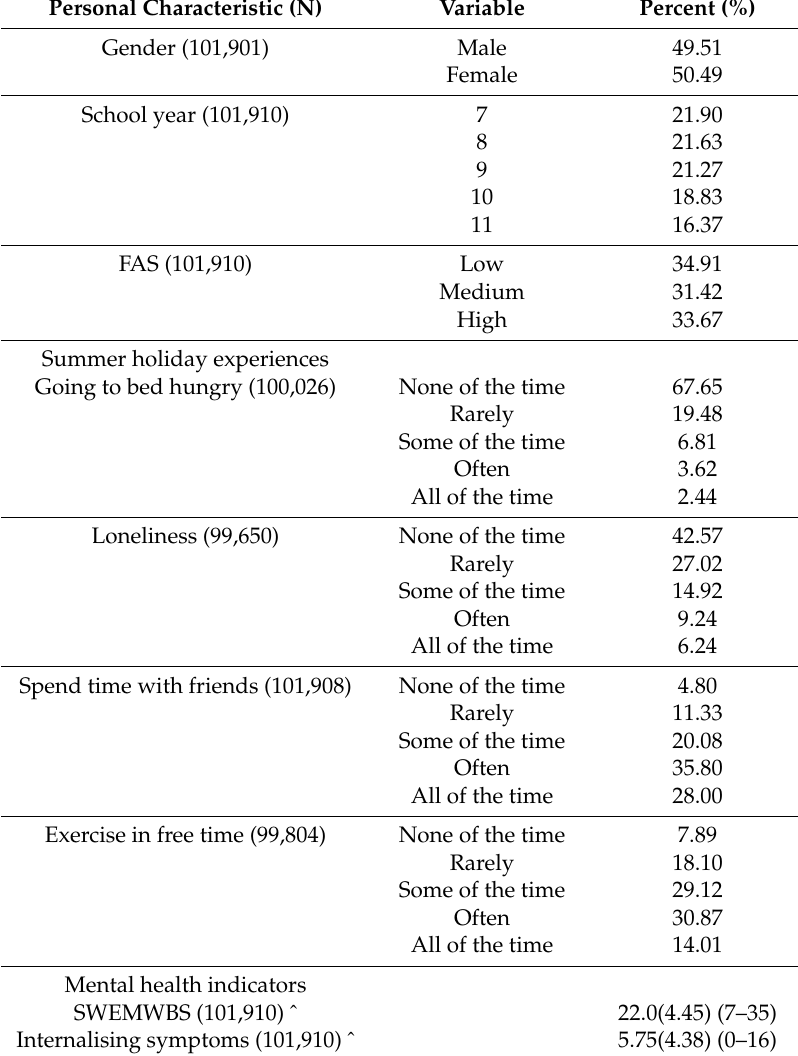
Table 1. Demographic and socioeconomic characteristics of the study